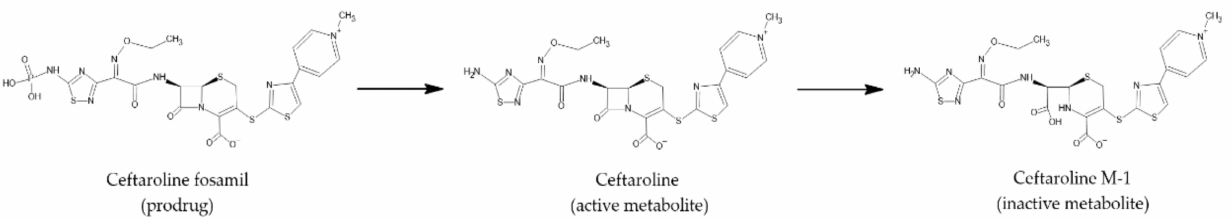
Figure 1. Chemical structure of ceftaroline fosamil, ceftaroline and ceftaroline M-1.